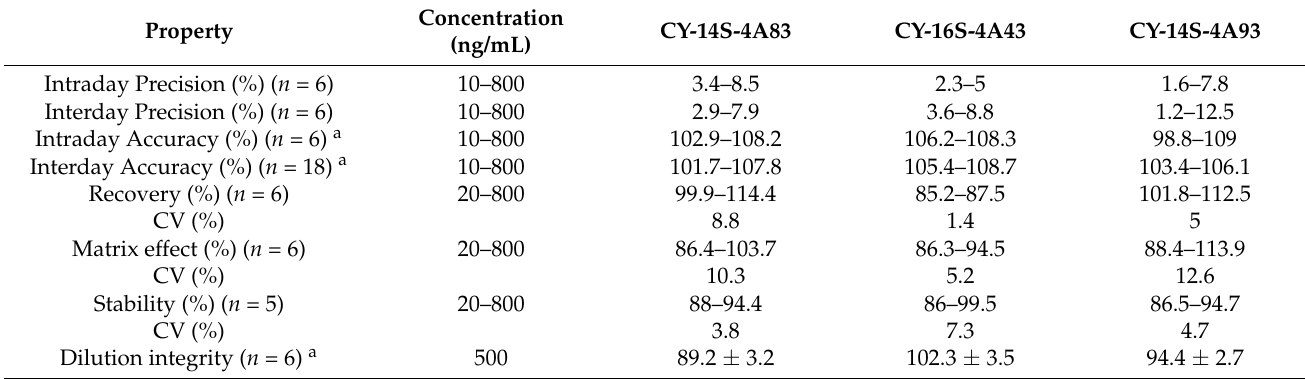
Table 2. Intra- and interday precisions and the accuracy, recovery, and matrix effects of